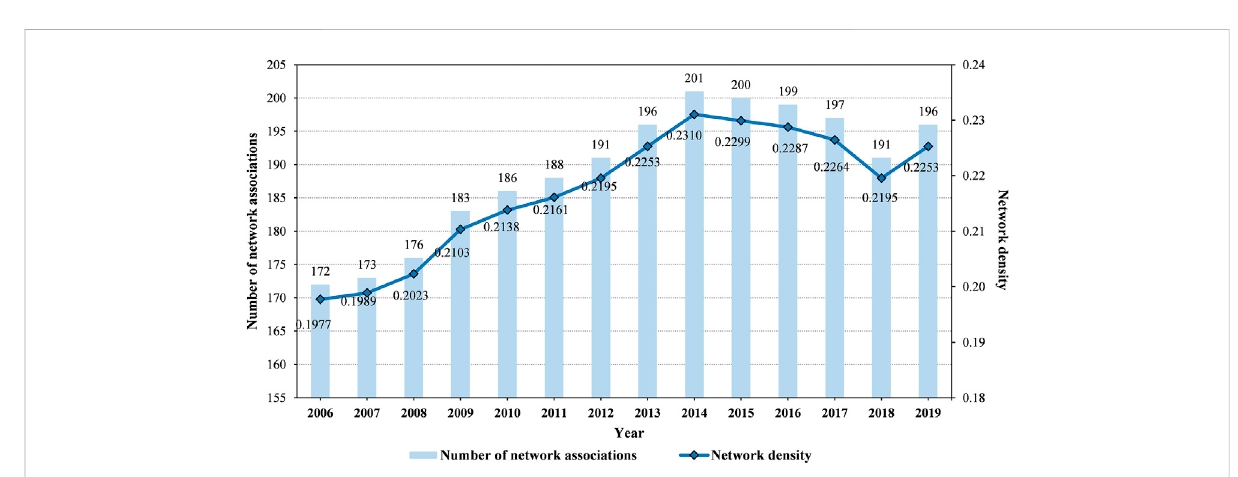
FIGURE 4 The density and the number of network associations of the transportation GTFP